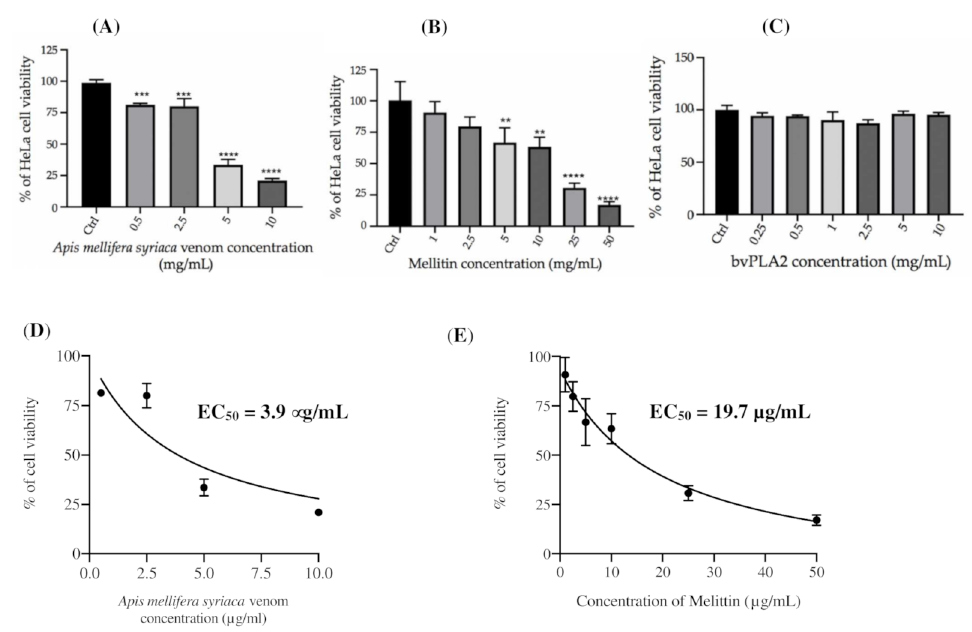
Figure 3. Cell viability of HeLa cancer cells, as measured by MTT test after treatment with increased concentrations of ( A ) A. mellifera syriaca venom, ( B ) MEL, and ( C ) Bv-PLA2. The results represent the mean ± SD of three independent experiments. Statistically significant compared with untreated cells (control): ** p < 0.01, *** p < 0.001, **** p < 0.0001. ( D ) Curve for MTT assay showing the EC 50 value and % of cell viability as a function of log concentration of A. mellifera syriaca venom. The obtained EC 50 of venom on HeLa cells was 3.9 µ g/mL. ( E ) Curve for MTT assay showing the EC 50 value and % of cell viability as a function of log concentration of melittin. The obtained EC 50 of melittin on HeLa cancer cells was 19.7 µ